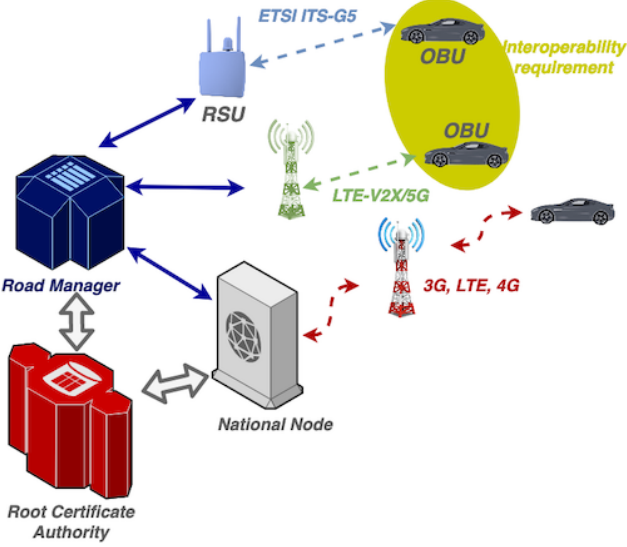
Figure 3. Network